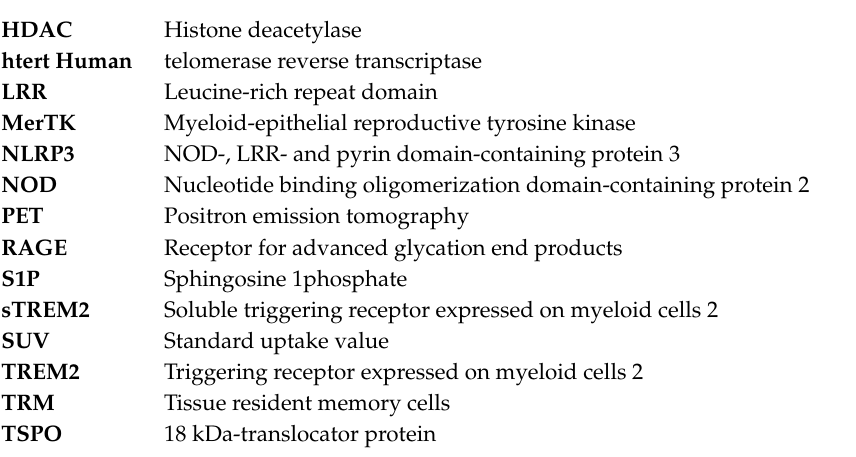
Figure 2. Sphingosine 1 phosphate receptor ligands.